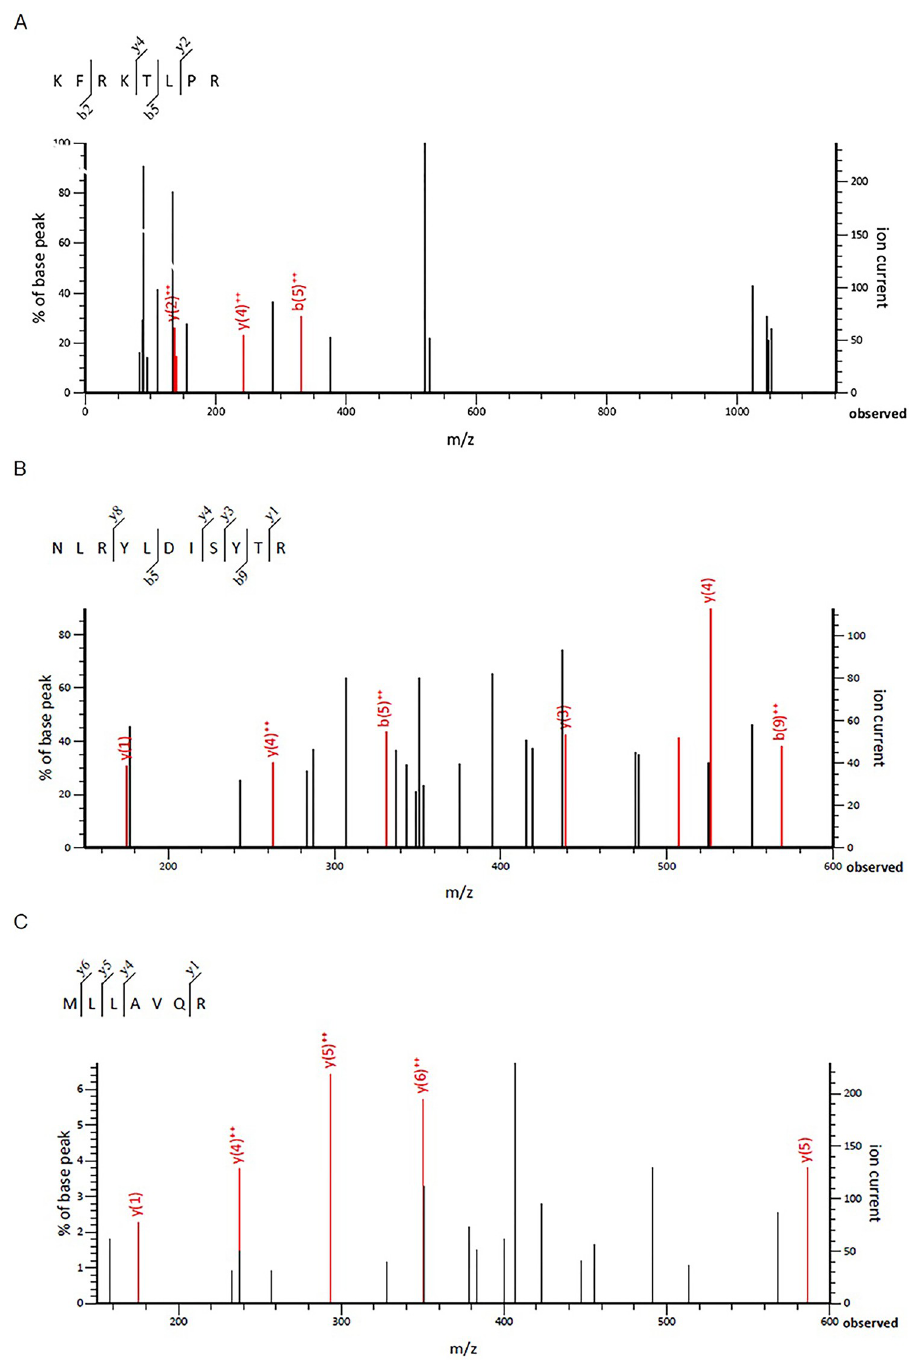
Fig 11. Verification of expressed protein sequences by LC-MS/MS. MS/MS fragmentations of KFRKTLPR found in SENP7 (A) , NLRYLDISYTR found in TLR4 (B) , and MLLAVQR found in NF- κ B (C) were shown. Mass spectral peaks were analyzed for peptide and nominated protein identification. Differ- ential protein expression has been revealed in canine oral tumors by MALDI-TOF MS coupled with LC-MS/MS and by in-gel digestion coupled with mass spectrometry (GeLC MS/MS) from tissues of oral tumors [33]. We did not find similar proteins to those from tumor tissues